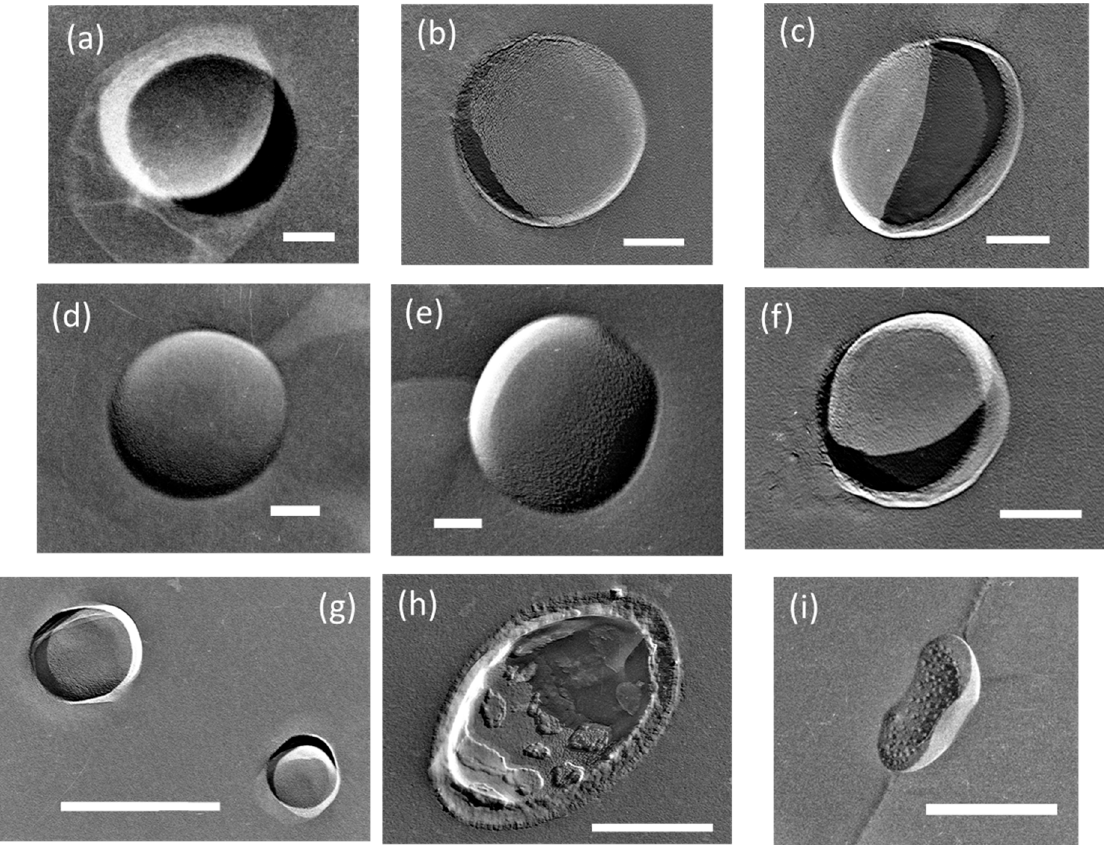
Figure 1. Typical TEM images of UFBs in each solution. ( a ) I-W , ( b ) I-BT , and ( c ) II-BT as initial conditions, ( d ) I-P and ( e ) II-P as transporting conditions, ( f ) I-R and ( g ) II-R as near-plant conditions. Each symbol shows the following: I = prepared with UFB generator, II = control water without UFB generator. The other symbols indicate location: BT = buffer tank; P = irrigation pipe; and R = rhizosphere. I-W is the tap water before entering the UFB generator. ( h ) A unique UFB from